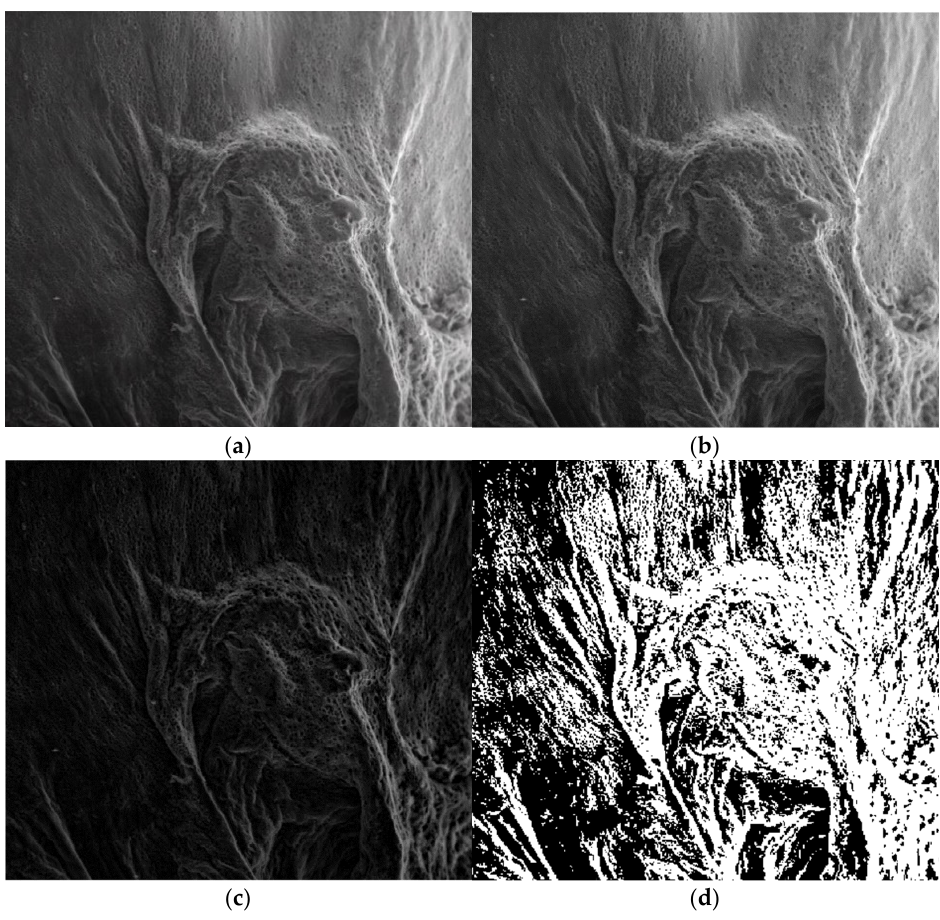
Figure 15. Processing stages of the image P 3 . ( a ) Original image (the entire portion); ( b ) grayscale version; ( c ) grayscale version without luminance; ( d ) binarized version. Table 3. Calculation of fractal characteristics of picture P 3